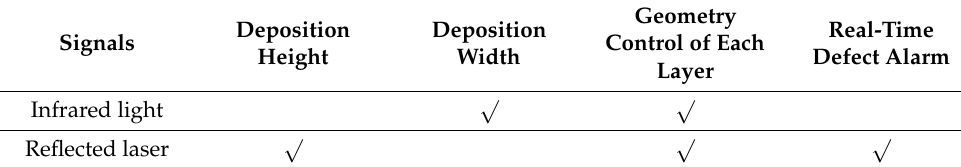
Table 2. Potential application of infrared light and reflected